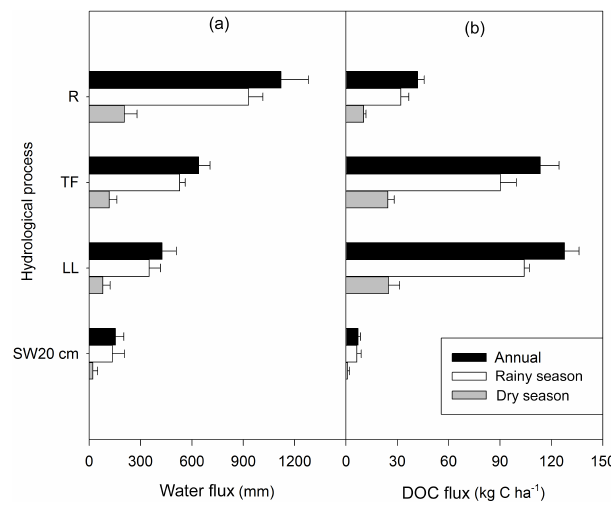
Figure 1. (a) Amount of water and (b) DOC flux along the hydro- logical processes in the tropical rainforest at Xishuangbanna, south- west